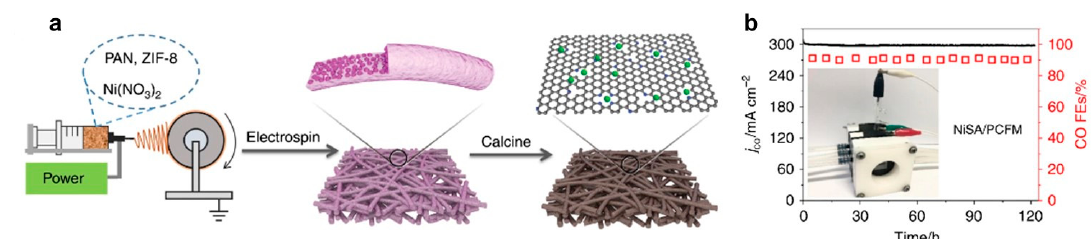
Figure 15. A robust Ni single atom supported on porous carbon fibers membrane (NiSA/PCFM): ( a ) schematic synthesis; ( b ) the results of current density (black line) and FE (red squares) for CO production long-term stability tests in a GDL-based flow cell at − 1.0 V RHE (reproduced with permission from ref. [124], copyright 2020, Springer